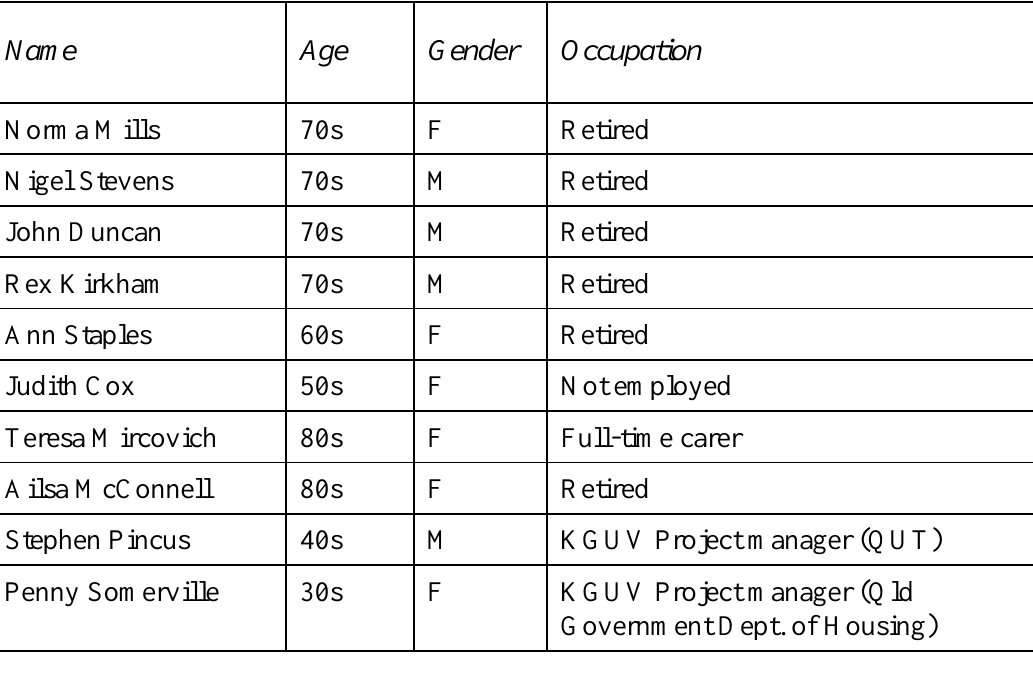
Table 4: Participants at second KGUV Sharing Stories